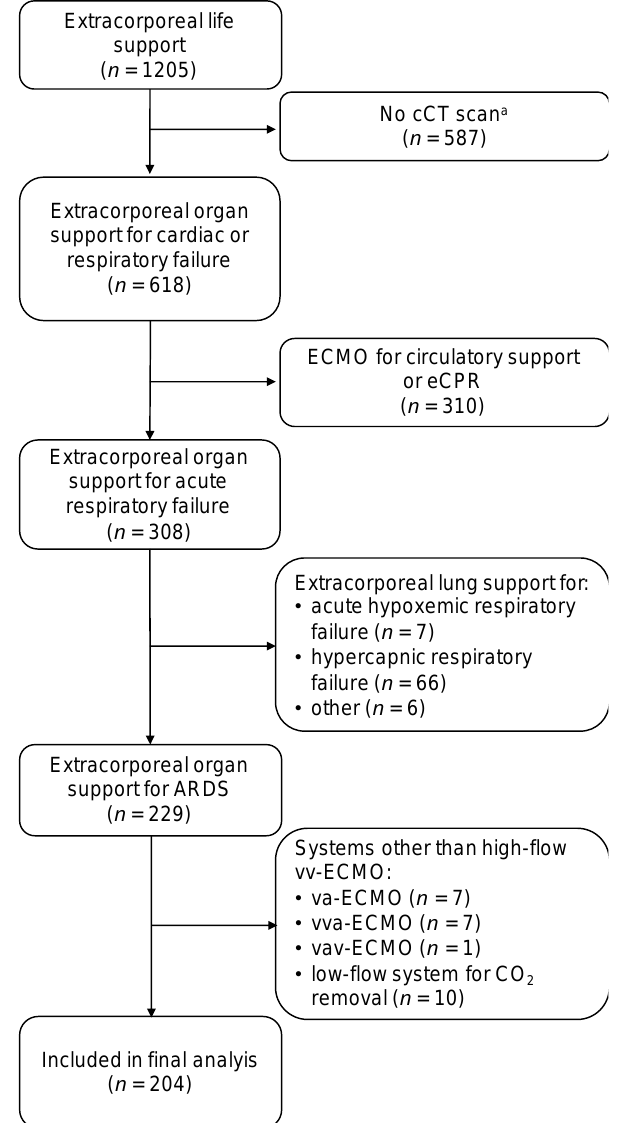
Figure 1. Flow diagram of patient selection during the study period (2011–2021). ARDS: acute respiratory distress syndrome. CCT: cranial computed tomography. CO 2 : carbon dioxide. Vv-/va-/vva-/vav-ECMO: veno-venous/veno-arterial/veno-veno-arterial/veno-arterio-venous extracorporeal membrane oxygenation. eCPR: extracorporeal cardiopulmonary resuscitation. a Patients, who did not receive a cCT scan during ECMO support or within the first 72 h after ECMO removal, were